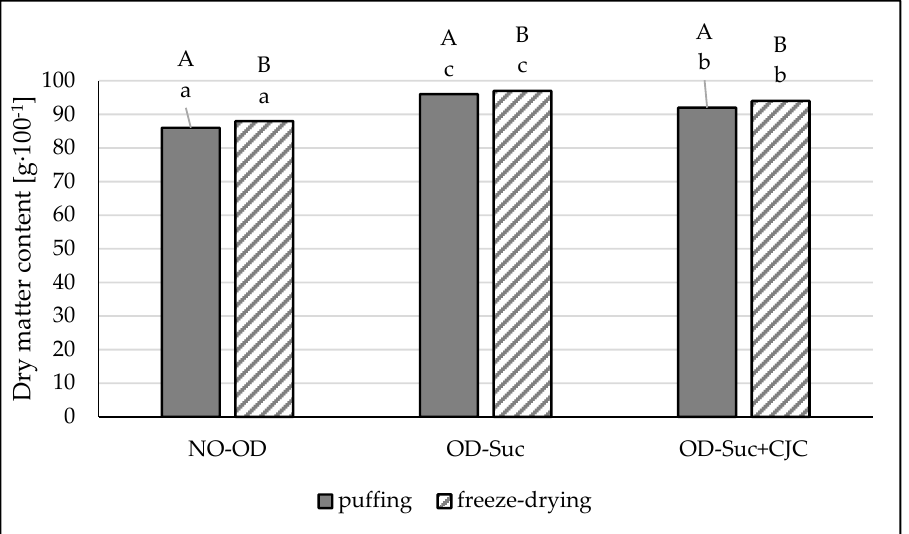
Figure 1. The influence of the type of osmotic solution and drying method on the dry matter content in apple samples dried by “puffing” or freeze-drying way; no pre-treated (NO-OD), pre-osmotic dehydrated in sucrose (OD-Suc) or in sucrose with chokeberry juice concentrate solution (OD-Suc + CJC). The same letter, a, b, c indicates a lack of statistically significant differences in the type of osmotic solution and A, B in the drying method.